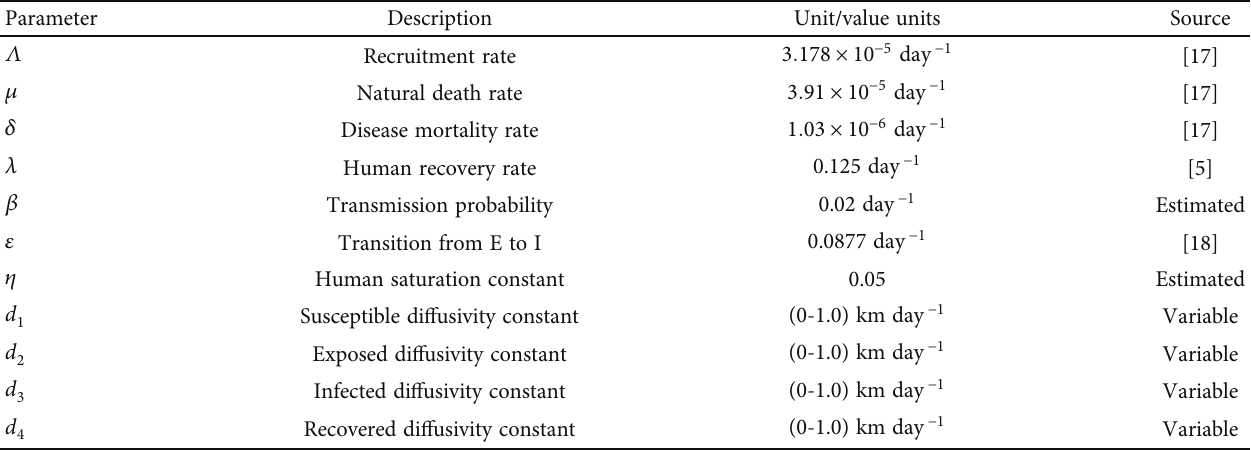
Table 1: The descriptive summary of the model